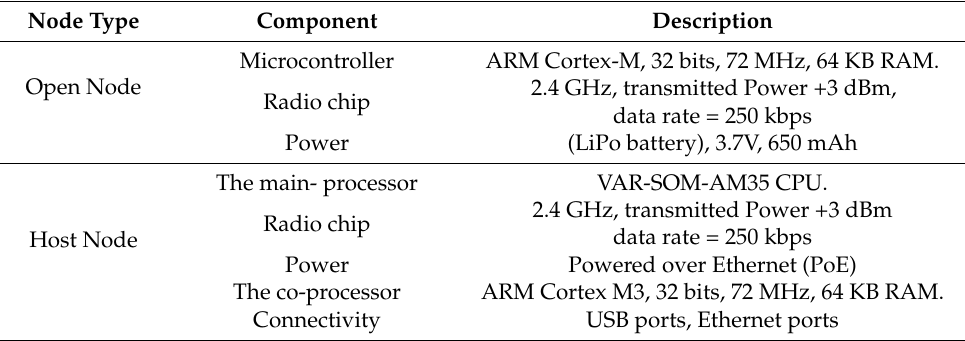
Figure 4. Lille–testbed network grid over ceiling and wooden poles in Inria building floors. Table 1. IoT‐LAB wireless open and host node components.